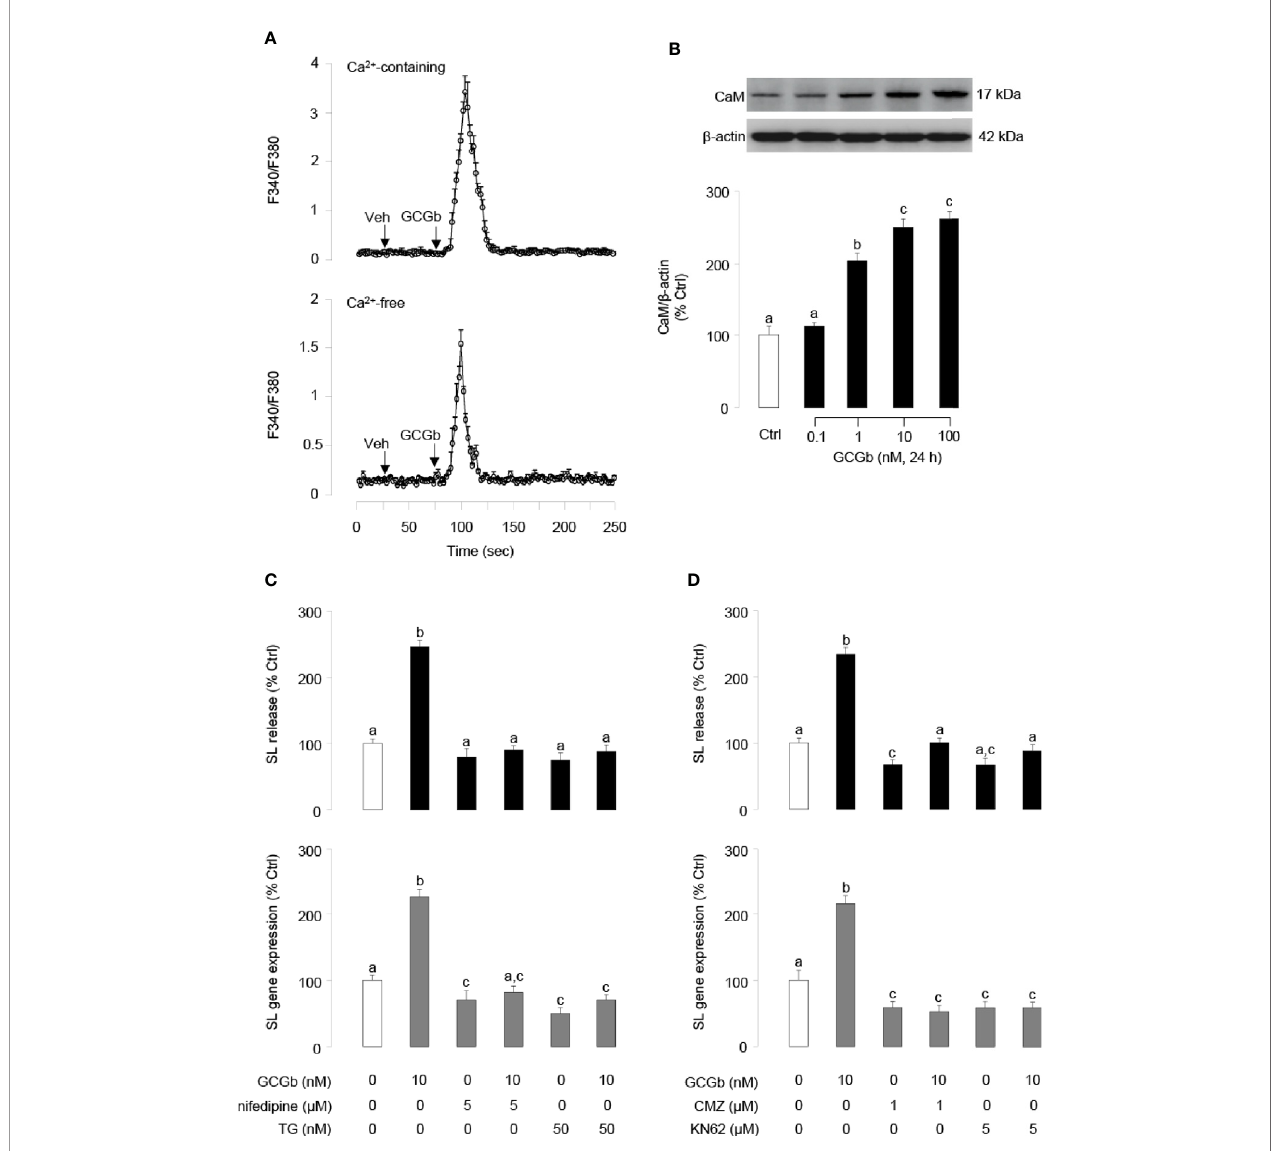
FIGURE 8 | GCGb activation of Ca 2+ /calmodulin (CaM)-dependent cascades in SL release and gene expression. (A) The effect of GCGb on total Ca 2+ signals (upper panel) and [Ca 2+ ]i mobilization signals (lower panel) in tilapia NIL cells. In this case, NIL cells were preloaded with the Ca 2+ -sensitive dye Fura-2 and treated with GCGb (10 nM) in a normal culture medium (with 2.5 mM CaCl2) or in a Ca 2+ -free medium supplemented with 0.1 mM EGTA for up to 250 s. (B) The stimulatory effects of GCGb (1 – 100 nM) on CaM protein levels in the NIL cells, measured by western blot and normalized by the internal control, b -actin (C) Effects of VSCC blockade and [Ca 2+ ]i depletion on GCGb-induced SL release (upper panel) and gene expression (lower panel). The GCGb (10 nM) is applied in the presence or absence of the VSCC blocker nifedipine (5 m M) or the SERCA inhibitor thapsigargin (TG, 50 nM). (D) Effects of CaM-dependent cascades blockade on GCGb- induced SL release (upper panel) and mRNA expression (lower panel). NIL cells are challenged with GCGb (10 nM) for 24 h in the presence or absence of the CaM antagonist calmidazolium (CMZ, 1 m M) or the CaMK-II inhibitor KN62 (5 m M). All results are expressed as the mean ± SEM (N = 3) and different superscript letters in each column show signi fi cant differences ( P < 0.05, ANOVA followed by a Bonferroni ’ s